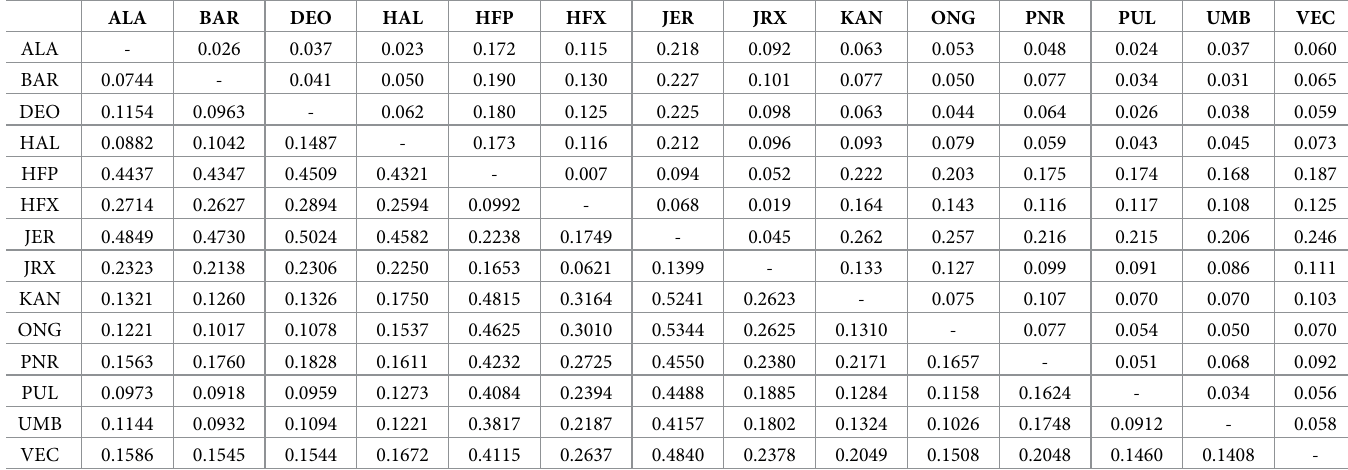
respectively. The results indicated 10.1% of the total genetic variation among all the studied cattle were due to between breed differences and it reduced to 5.7% when only zebu cattle breeds were considered. The global F among all cattle breeds/populations ranged from 0.052 ST